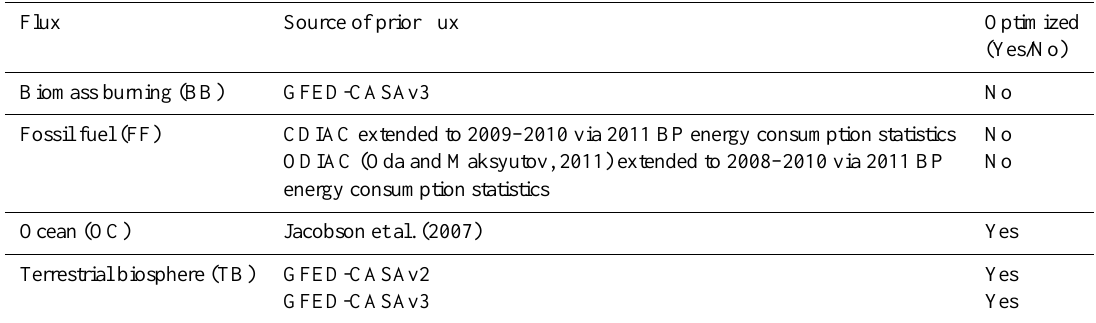
Table 1. Details of CT2011_oi prior and posterior fluxes used in this